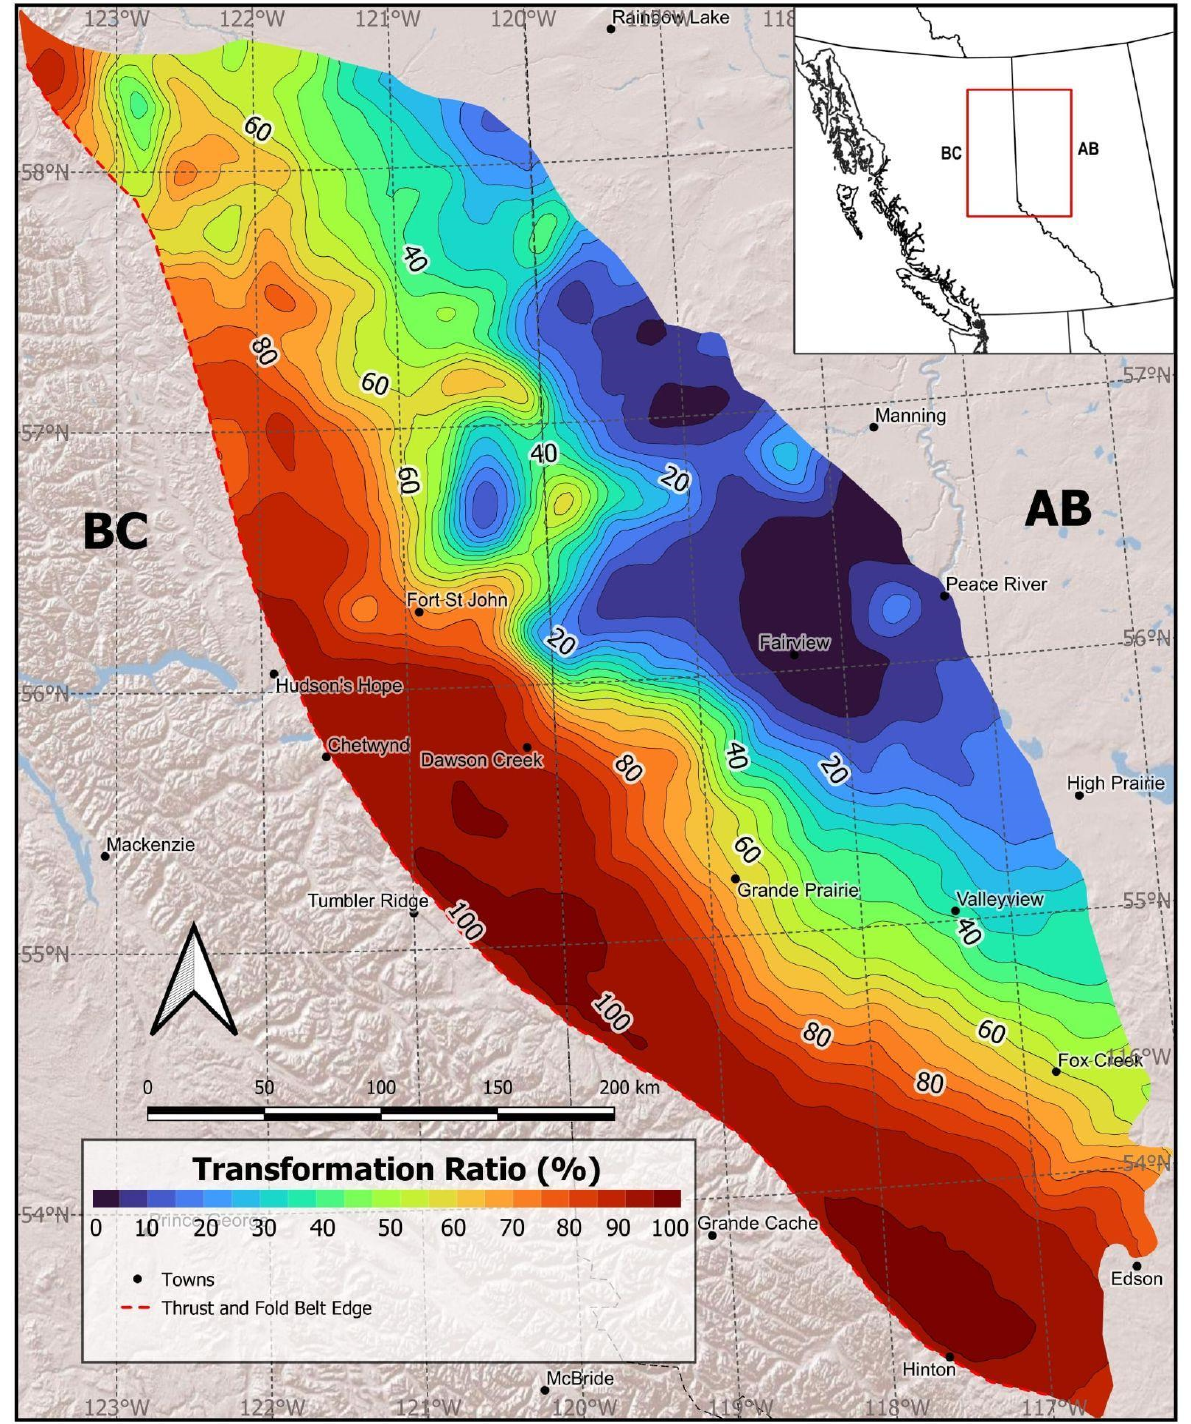
Figure 22. Kerogen transformation ratio in the Middle Montney Formation at 60 Ma. With continued rapid foreland subsidence, areas along the deformation were at 100% transformation ratios, and secondary cracking of wetter hydrocarbons to dry gas (SHCs) started in the deepest areas.